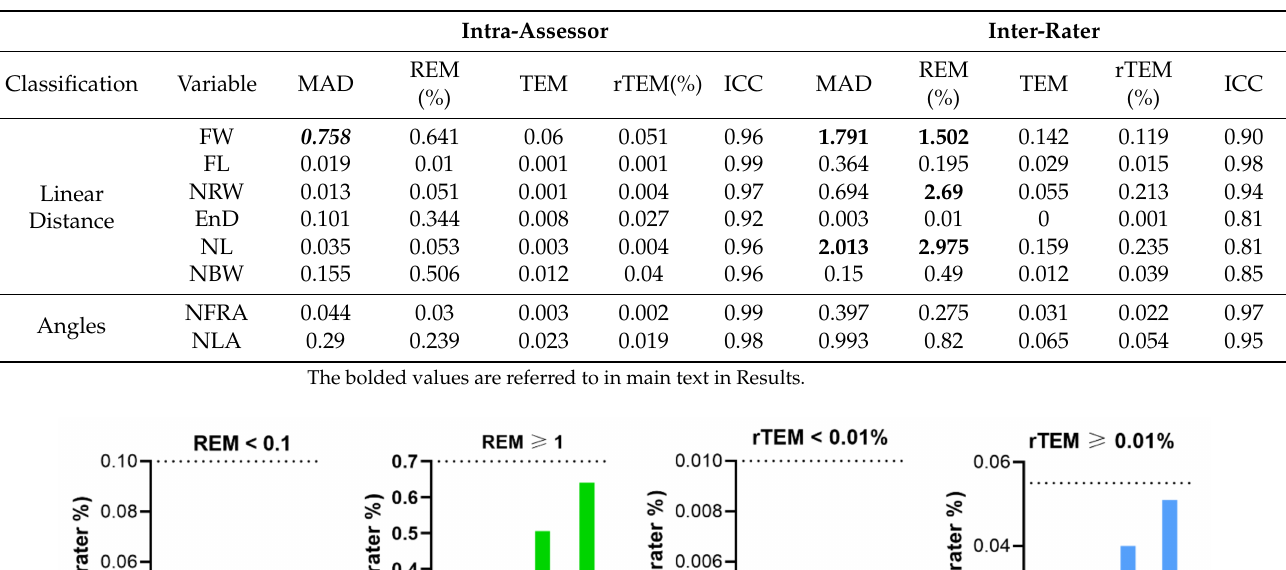
Table 5. The intra-assessor and inter-assessor reliability of classic parameters.